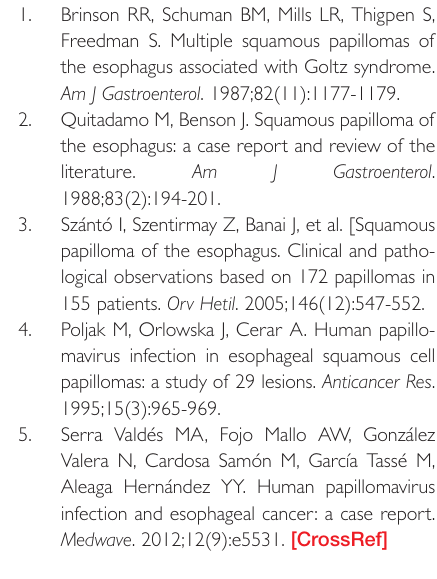
Figure 1A. The biopsy and the pathological study of the sample are considered essential for the diagnosis: a fibrovascular nucleus is classically observed, branching from the lamina propria to form finger-shaped projections without invasion toward the submucosa, completely surrounded by marked infiltration of neutrophils and cov- ered by an acanthotic squamous epithelium, 10 as seen in the image of the case study described in Figure